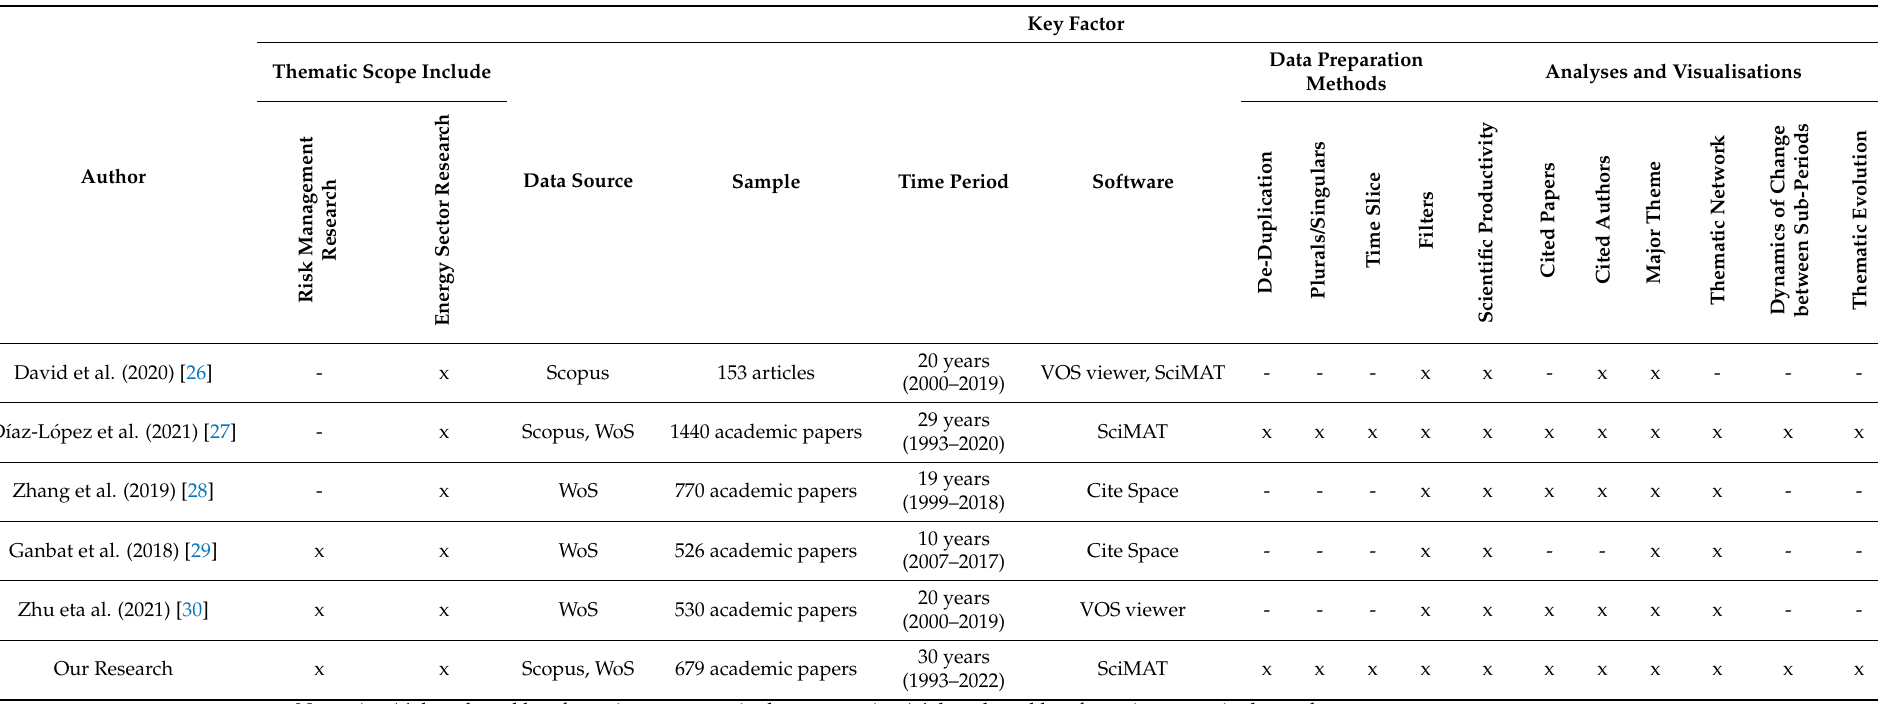
Table 1. A comparison of our study with similar studies on approaches to mapping risk management issues in the energy sector—key